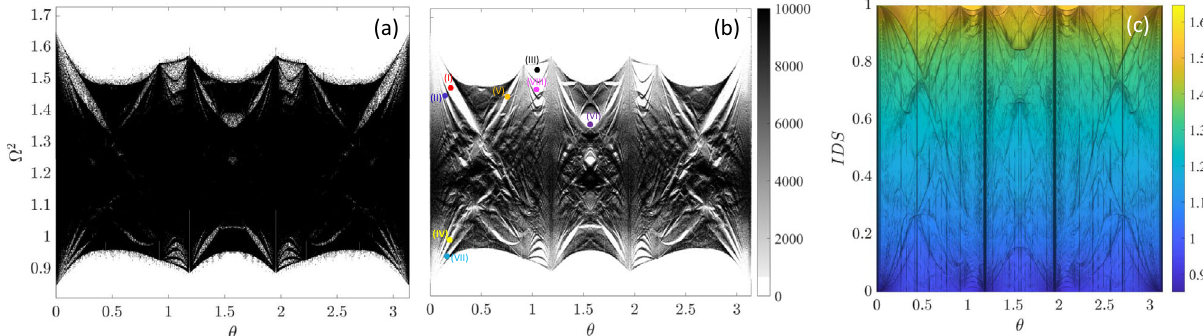
ffiffiffi p ; a Ω 2 ) of 100 × 100 lattice calculated with periodic boundary 7 1 ¼ a 2 ¼ 1. a Eigenfrequencies (